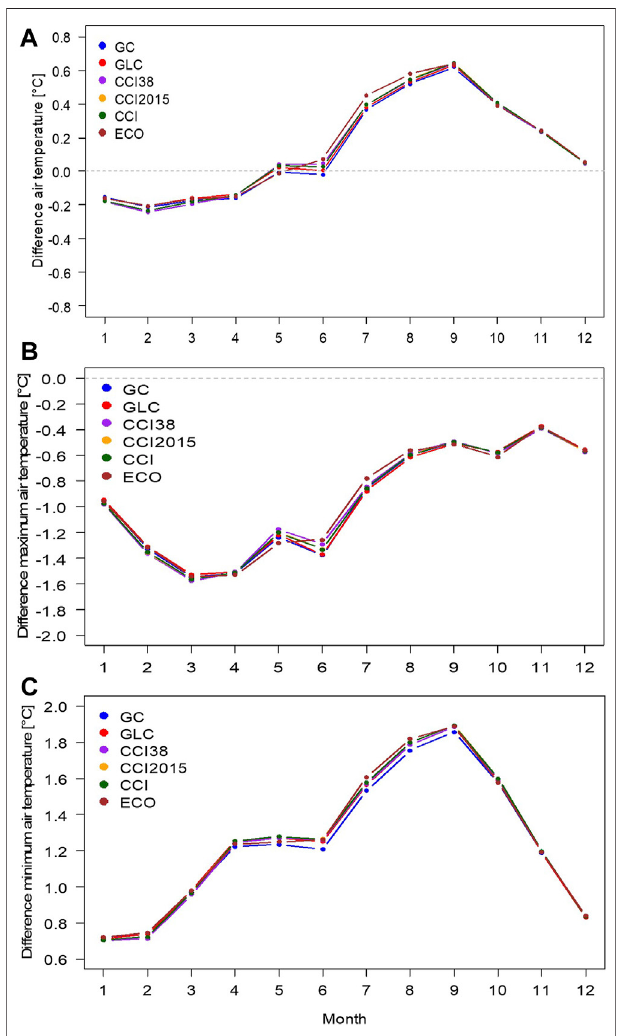
FIGURE 3 | Annual cycle climatology (2002 – 2011) of the differences in 2-m temperature (A) , maximum temperature (B) and minimum temperature (C) in the simulation experiments with land cover map GC (blue), GLC (red), CCI38 (purple), CCI 2015 (yellow), CCI (green), and ECO (brown) compared with the gridded observations. Please see Table 1 for abbreviations.